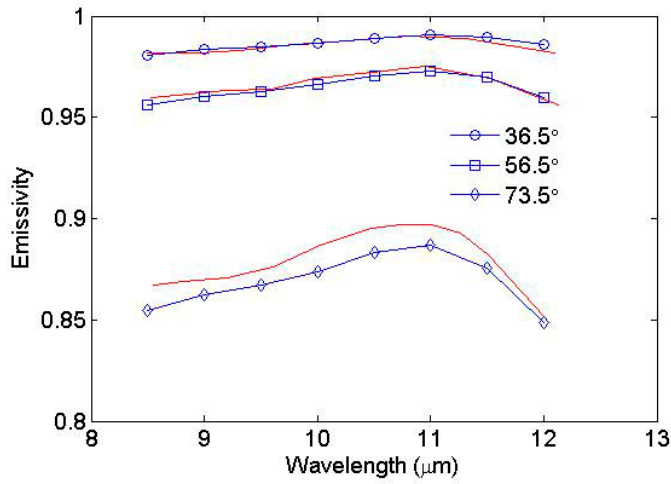
Figure 7. Simulated directional emissivity spectra versus in situ measured emissivities for view angles of 36.5°, 56.5° and 73.5°. The measured emissivities (red lines) are reproduced from Figure 10 by Smith et al. [27].